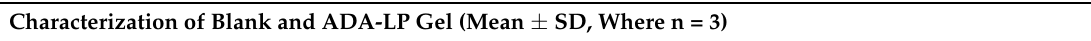
Figure 4. ( a ) 1% Carbopol blank gel. ( b ) Drug-loaded ADA-LP gel in 1% Carbopol. Table 3. Characterization of Blank and ADA-LP